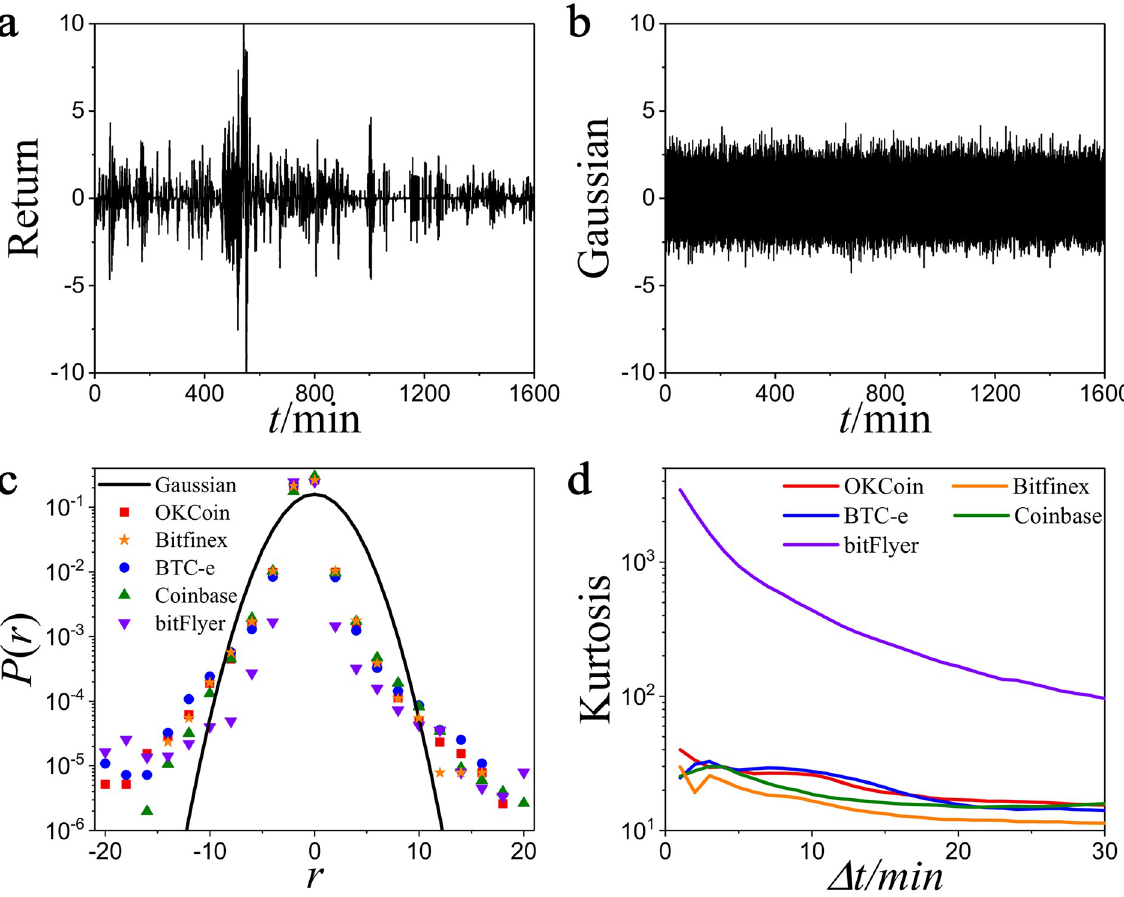
Fig 1. The fat-tail of price return distribution. a , An example of normalized price return in OKCoin from 14:04 on March 3, 2017 to 22:45 on March 4, 2017. b , An example of noise signal sampled from a Gaussian distribution. c , The distribution of normalized price return in different Bitcoin platforms compared with Gaussian distribution when Δ t = 2 min. d , The kurtosis κ versus Δ t in different Bitcoin platforms.